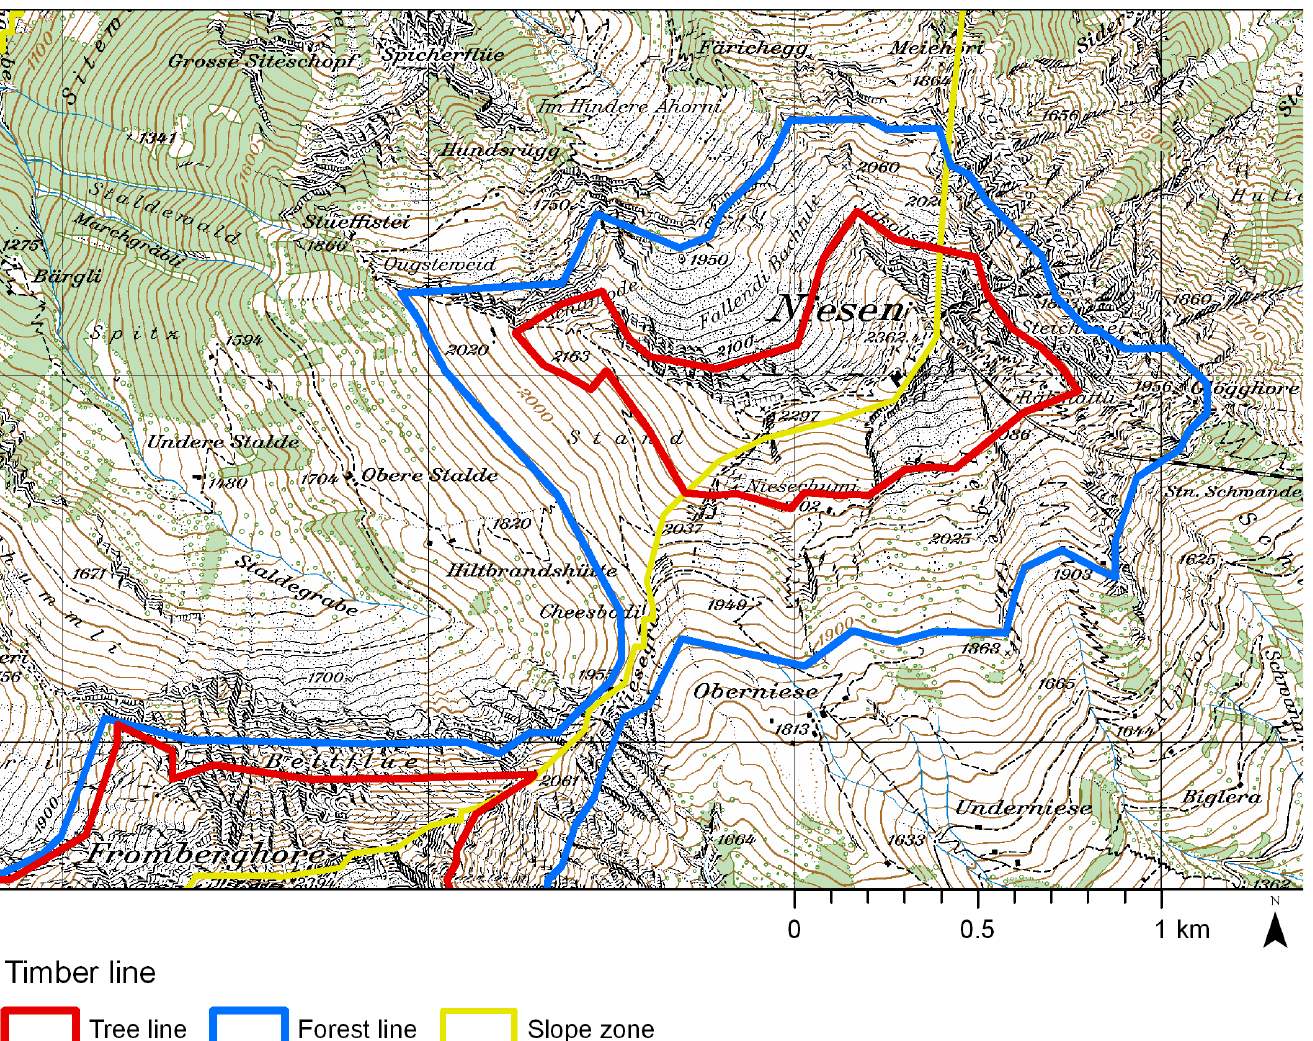
Figure 6. The peak of the Niesen exceeds the tree line by about 240 m in altitude and with an area of 0.57 km². The Topographic Map 1:25,000 (2009 © Swisstopo) is shown in the